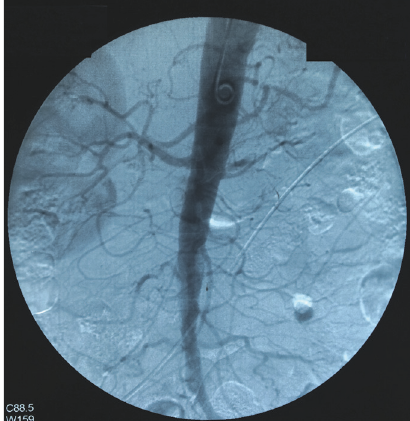
Figure 2: Digital subtraction angiography demonstrating left renal artery stenosis.